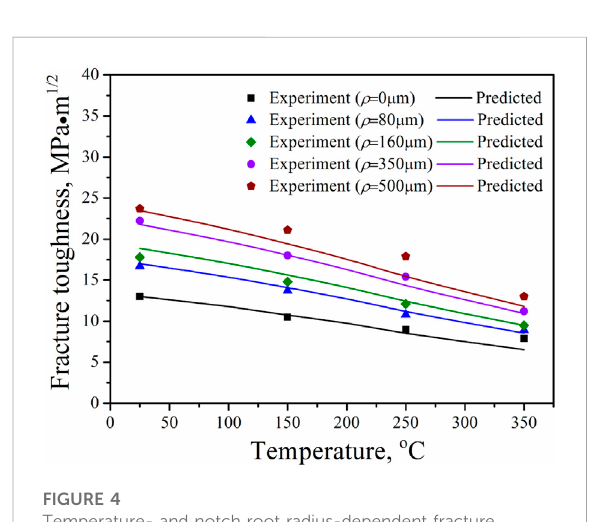
FIGURE 4 Temperature- and notch root radius-dependent fracture toughness of aluminum alloy (Srinivas and Kamat,